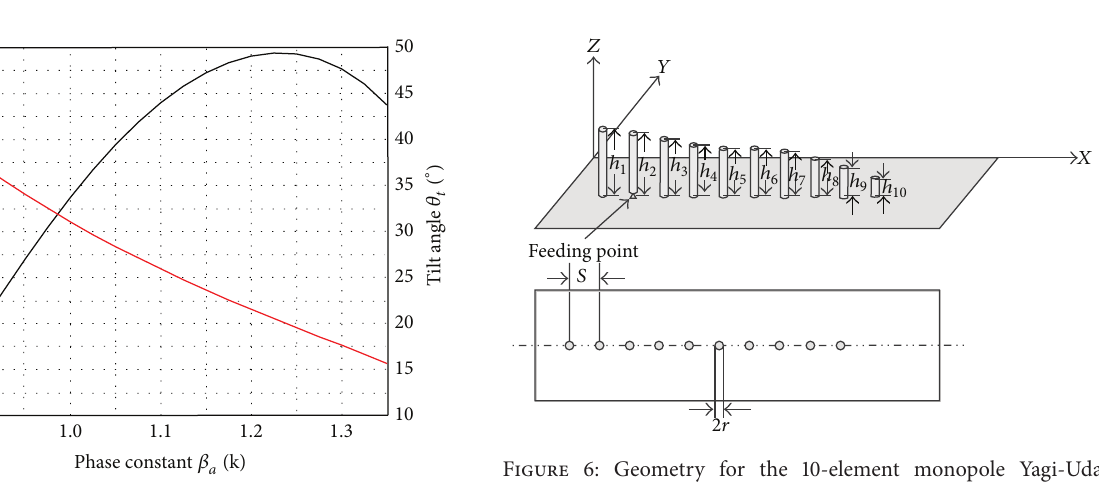
Figure 6: Geometry for the 10-element monopole Yagi-Uda